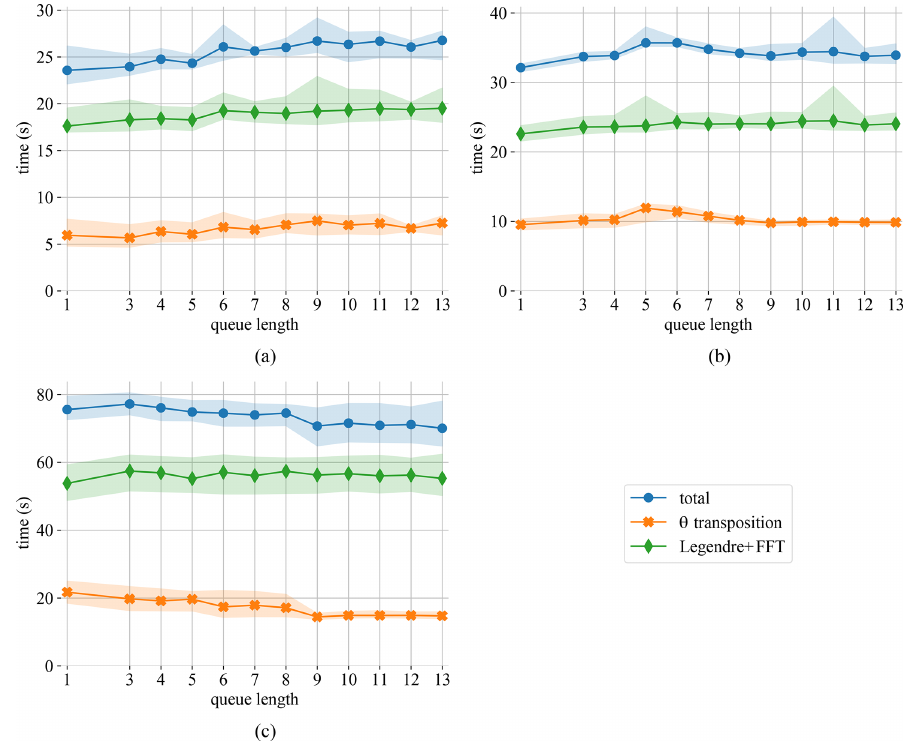
Figure 4. Runtime for the different components of the SHT in the intranuma (a) , intranode (b) , and internode (c) regimes. Data are for 50 time steps using the A2AW implementation.